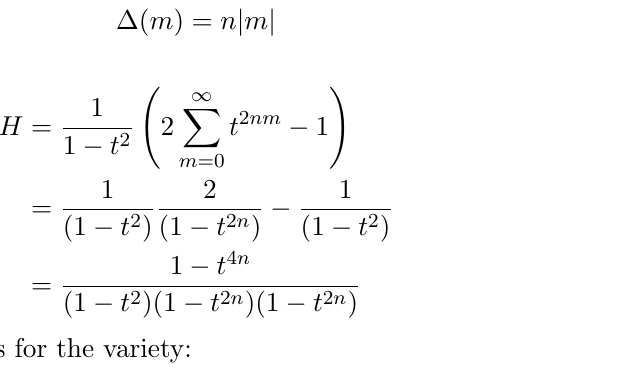
Figure 75. Quiver whose Coulomb branch is an A